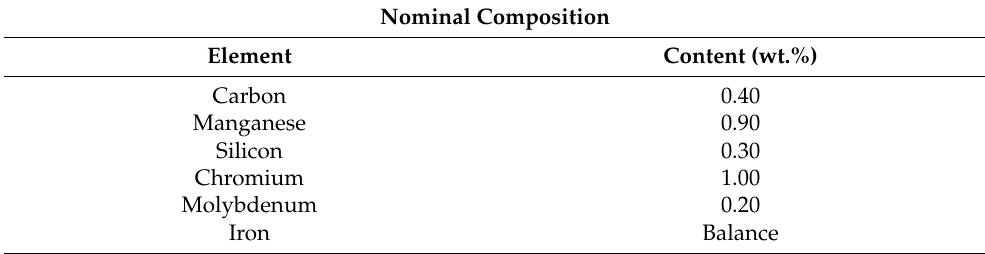
Table 2. Chemical composition of the AISI 4140